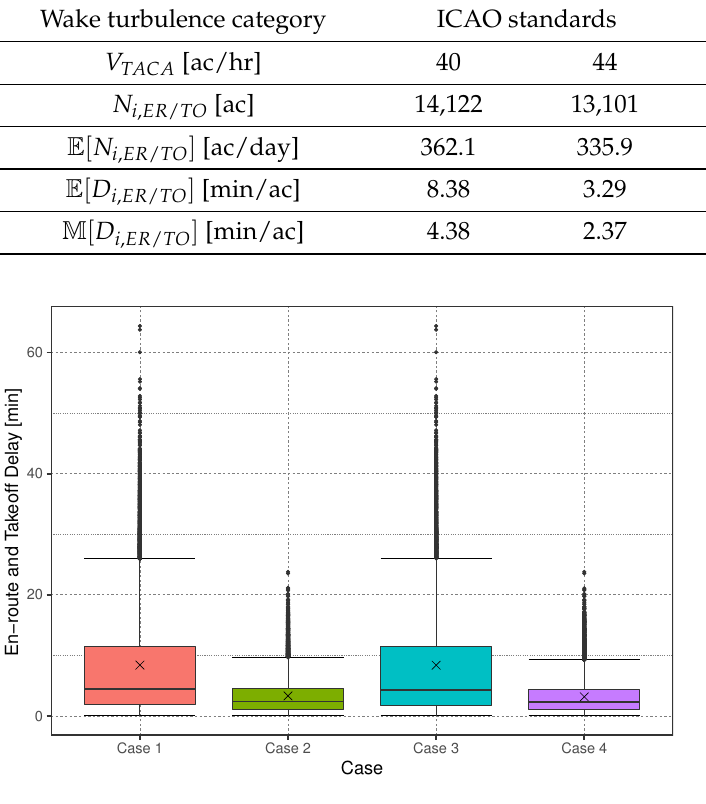
Figure 16. Comparison of en-route and takeoff